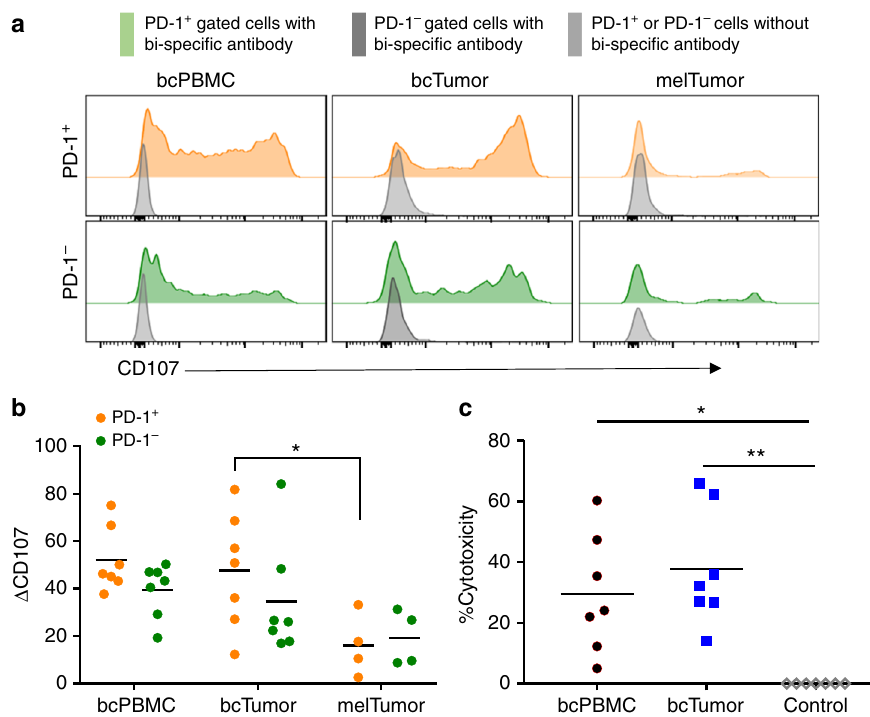
Fig. 7 PD-1 + CD8 + TILs from breast tumors retain cytotoxic capacity. a Non-naive CD8 + T cells isolated from bcPBMCs or bcTumor were cultured with CD19 expressing target cells and CD3-CD19 bi-speci fi c antibodies and analyzed for CD107 mobilization by fl ow cytometry as shown in representative plots. b Graph depicts change ( Δ ) in frequency of CD107 mobilizing CD8 + cells in co-cultures with bi-speci fi c antibody relative to those without. Parent gates were of PD-1 + and PD-1 − populations from bcPBMC and bcTumor CD8 + CD45RA − T cells. c Graph depicts cytotoxicity of bcPBMC and bcTumor CD8 + after overnight co-culture with bi-speci fi c antibodies and target cells. Signi fi cance was calculated using one-way ANOVA and Holm – Sidak multiple comparison tests; * p < 0.05; ** p <